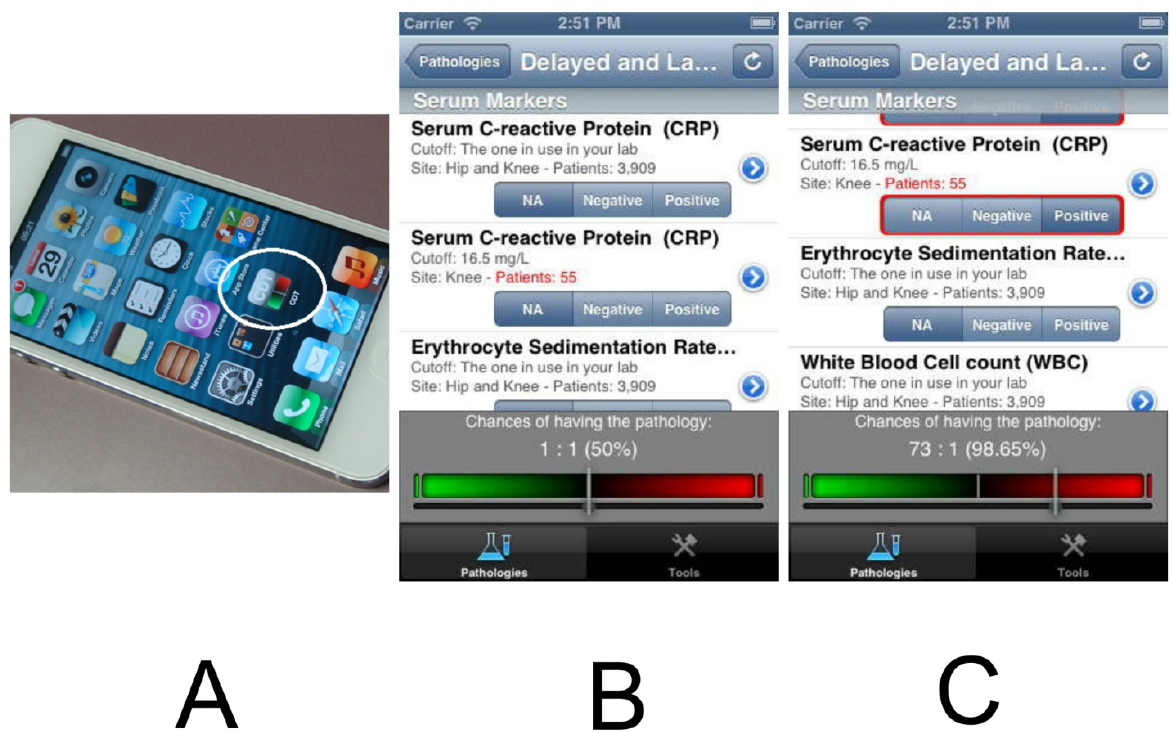
Figure 1. A. The “Combined Diagnostic Tool” or CDT App is designed for iOS devices (iPhone, Apple, California); B. and C. Screenshots showing, respectively, the App at baseline, with the reference bar set at 1:1 or 50% or after a combination of tests providing a chance of peri-prosthetic infection of 73 : 1 or